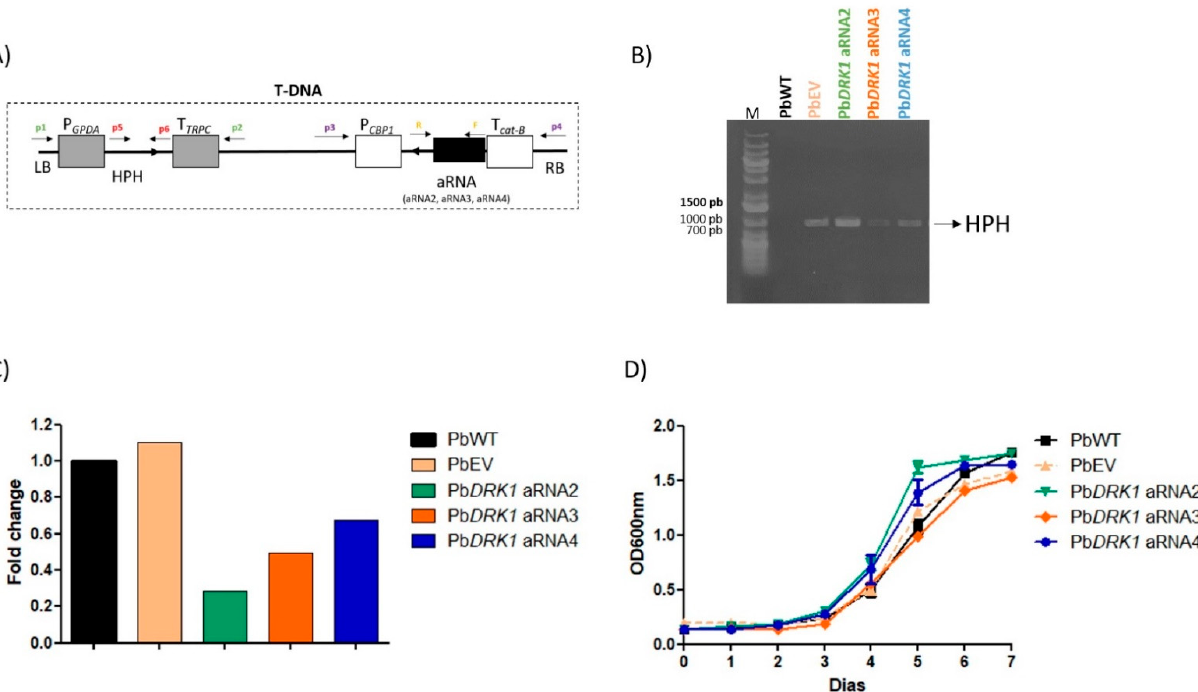
Figure 6. Knockdown of DRK1 of P. brasiliensis. ( A ) Transfer DNA (T-DNA) construct (carried out in the pUR5750 vector) for aRNA silencing of DRK1 via ATMT, containing the HPH (hygromycin B phosphotransferase) gene driven by the Aspergillus nidulans GPDA (glyceraldehyde 3-phosphate) promoter and TRPC (transcriptional terminator) with aRNA oligonucleotides under the control of CBP1 (calcium-binding protein) promoter from H. capsulatum and cat -B gene from Aspergillus fumigatus. ( B ) After selecting stable mitotic clones, hygromycin-resistant, three isolates (Pb DRK1 aRNA2, Pb DRK1 aRNA3, and Pb DRK1 aRNA4) were selected, and the HPH gene amplification by PCR was performed to confirm the presence of T-DNA. ( C ) The relative DRK1 expression levels in the Pb DRK1 aRNAs were determined by qRT-PCR com- pared to PbWT (that was set at 100%). The L34 reference gene was used as an endogenous control to normalize the relative DRK1 expression levels. ( D ) Growth of PbWT, PbEV, and Pb DRK1 aRNA strains. Yeasts from all strains were cultivated at 37 °C for seven days, and the growth curve profiles were determined by reading the optical density at 600 nm every 24 h.